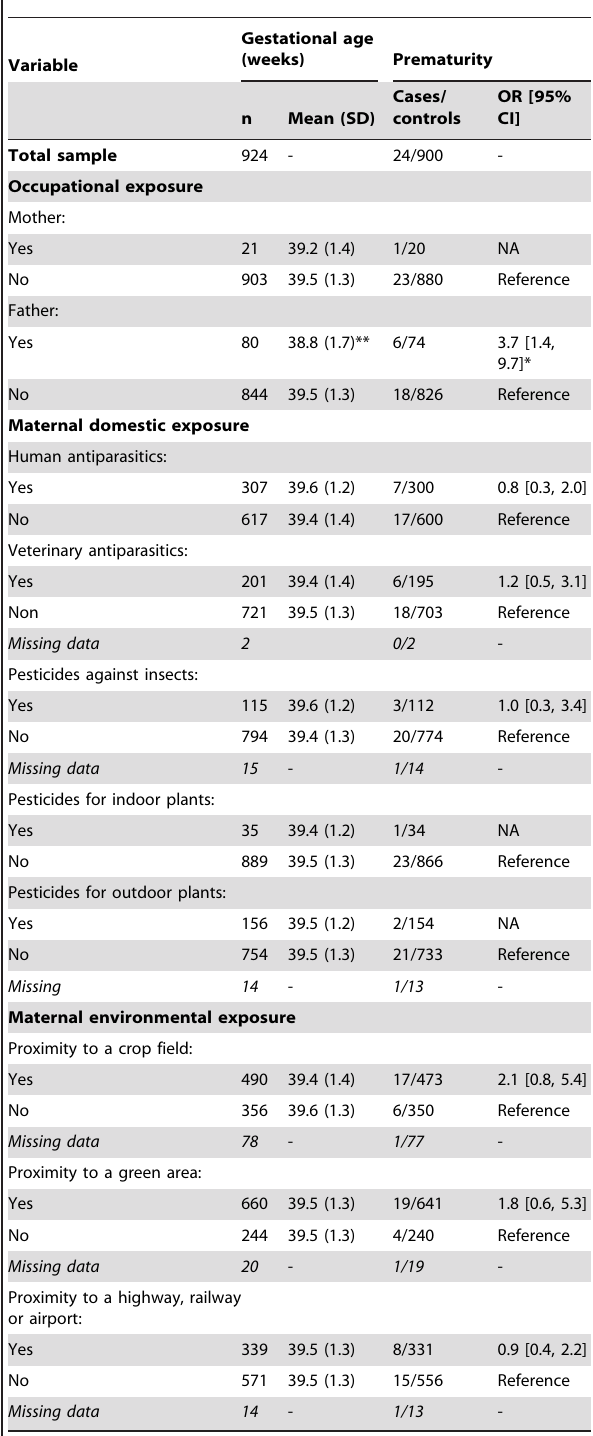
Table 5. Multivariate associations between factors related to in utero exposure to pesticides and gestational age and